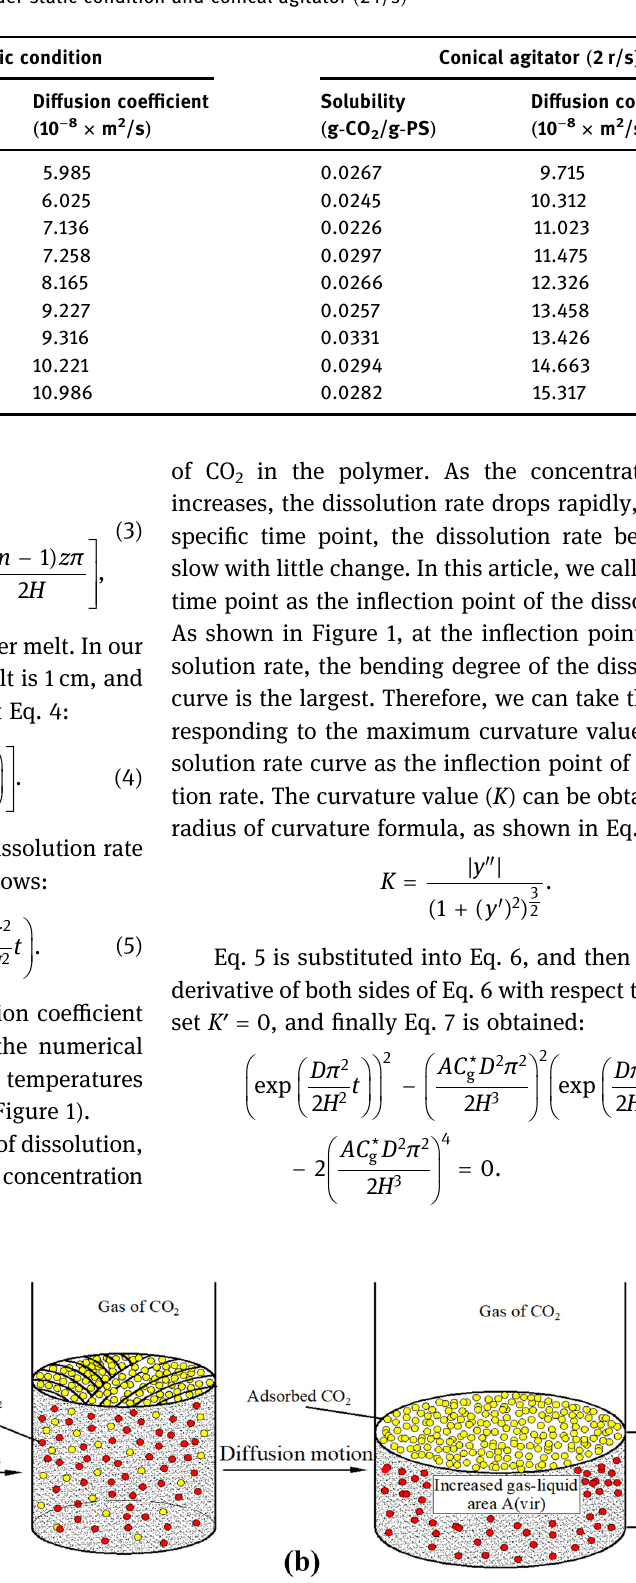
Table 1: The solubility and di ff usion coe ffi cient under static condition and conical agitator ( 2 r/s )